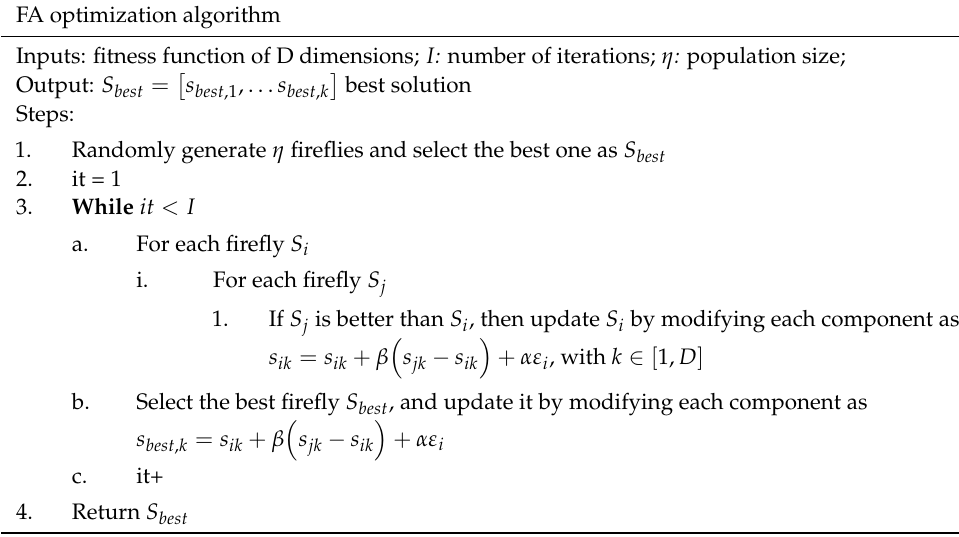
Algorithm 3. Pseudo code of the FA algorithm. FA optimization